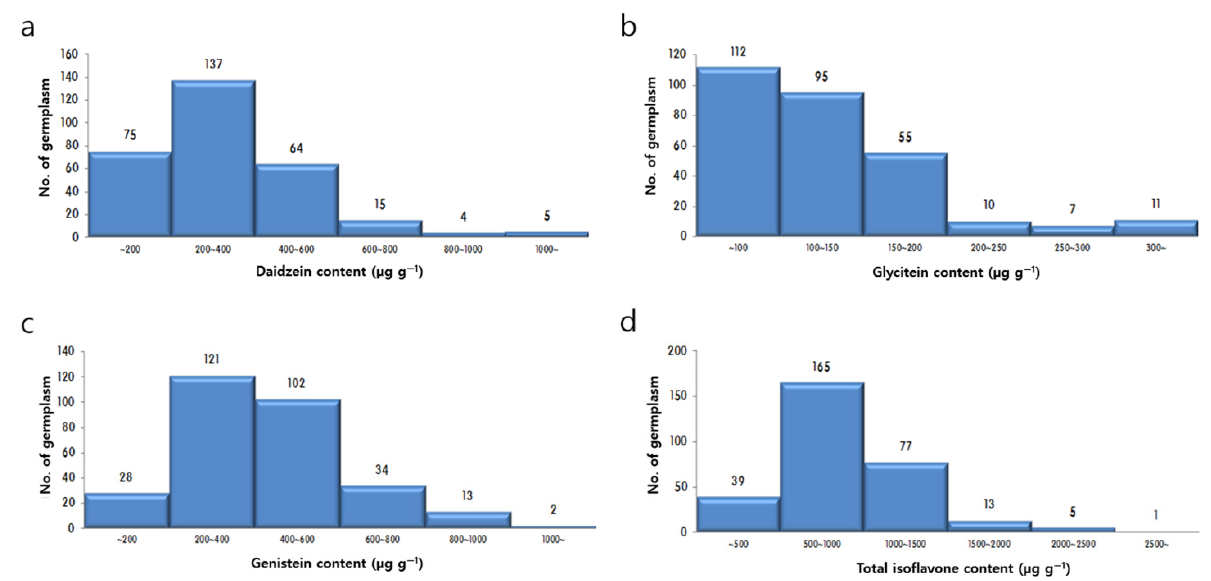
Figure 2. Frequency distributions of daidzein ( a ), glycitein ( b ), genistein ( c ) and total isoflavone ( d ) contents in 300 soybean germplasms.